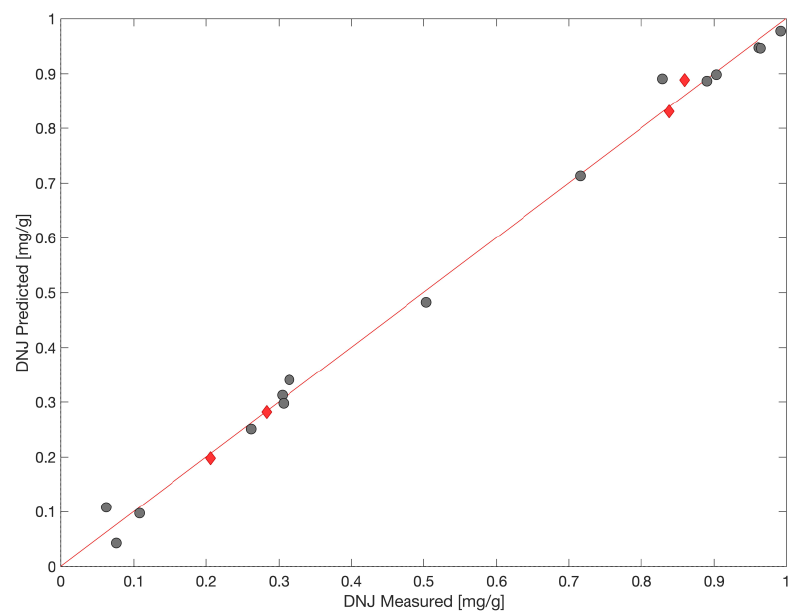
Figure 7. Results of iPLS model. Relationships between measured and predicted values of DNJ concentration using the model ( • —calibration set, (cid:7) —test set). LV number = 6; cross-validation method: leave-one-out; RMSE CAL = 0.025; RMSE CV = 0.095; RMSE PRED = 0.016; R 2 CAL = 0.995.